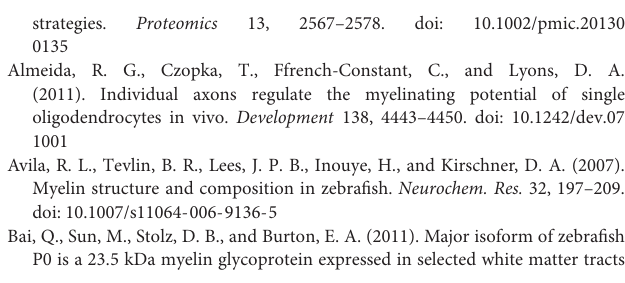
Supplementary Table 1 | Compendium of the zebrafish myelin proteome. Sheet 1: 1D gel separation of proteins followed by in-gel digestion and LC-MS analysis (890 proteins). Sheet 2: 1D gel separation of proteins after membrane wash followed by in-gel digestion and LC-MS analysis (1,274 proteins). Sheet 3: In-solution digestion of proteins and label-free quantification by MS E (562 proteins). Sheet 4: In-solution digestion of proteins and label-free quantification